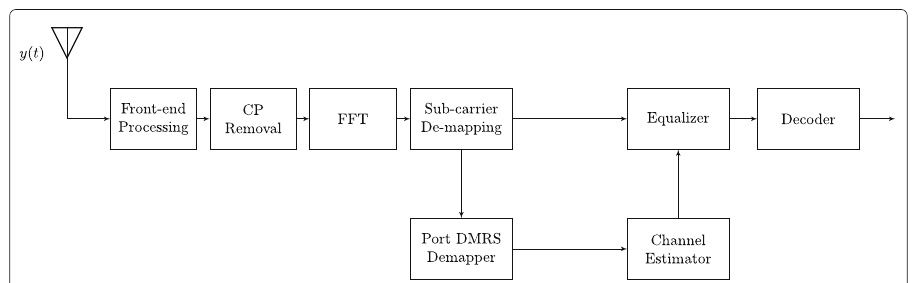
Fig. 12 Base station receiver architecture for each receiver